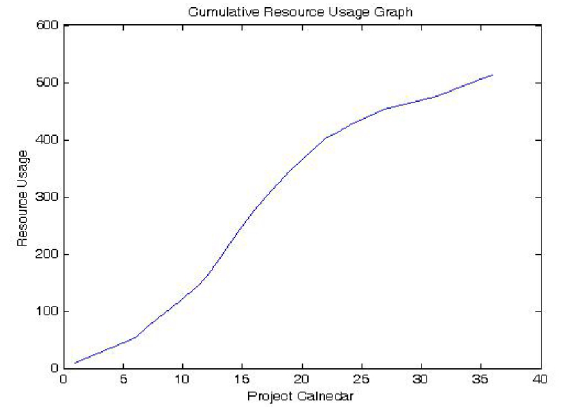
Figure 13. Cumulative resource usage for resource 2 of experiment 1 (after using forward method)